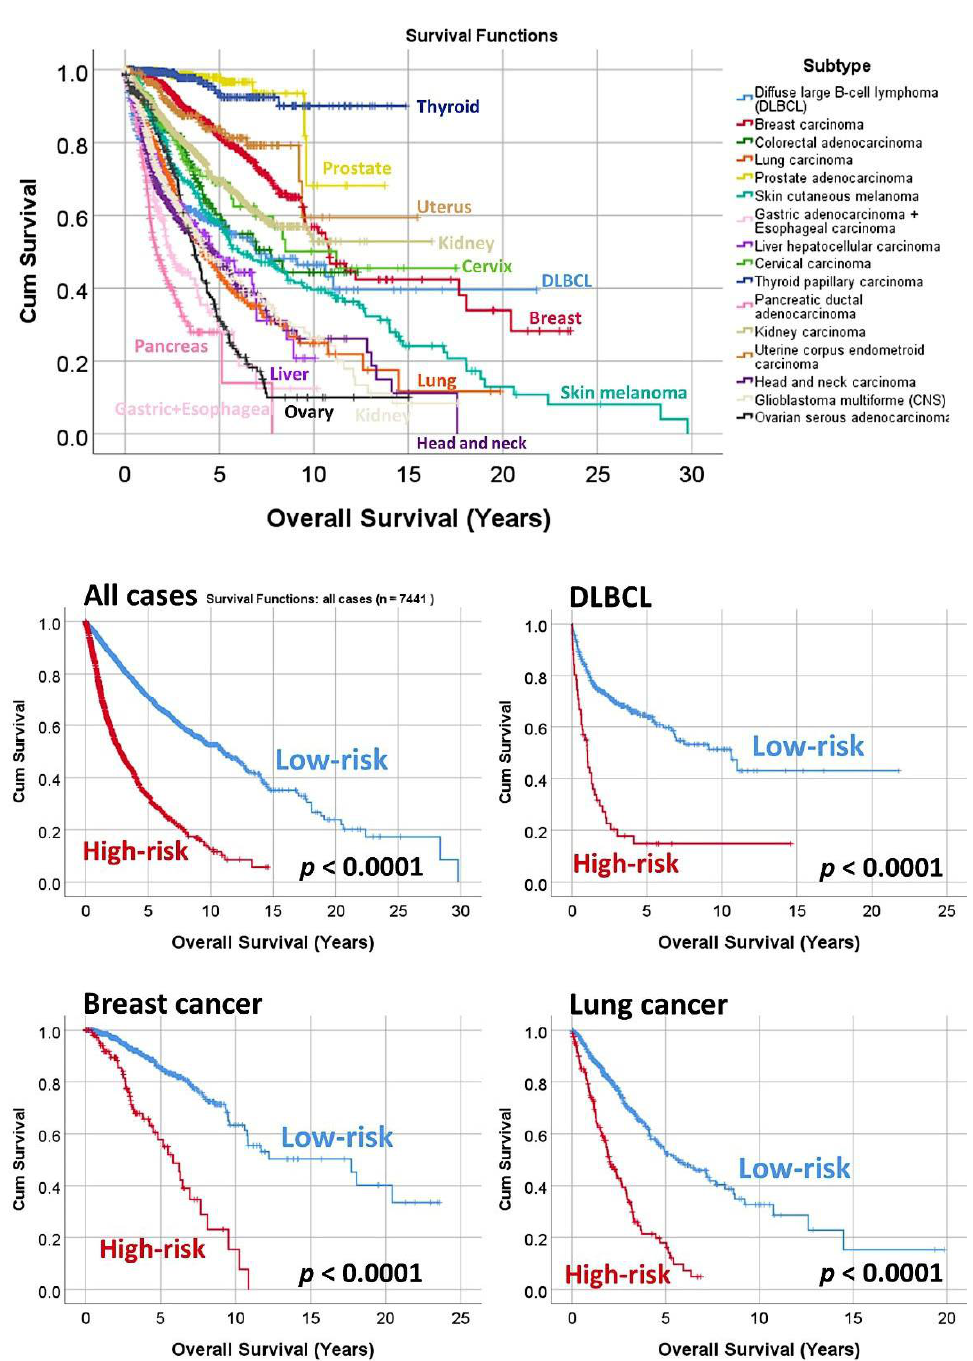
Figure 8. Predictive value for the overall survival of the top 30 genes of the MLP. Using the gene expression of 30 genes, previously identified by the MLP analysis, and a risk-score formula, the overall survival of diffuse large B-cell lymphoma and the most relevant subtypes of cancers were calculated. All cases, Log-rank (Mantel–Cox) p -value = 5.1 × 10 − 202 ; DLBCL, p = 5.7 × 10 − 15 ; breast cancer, p = 1.4 × 10 − 16 ; lung cancer, p = 4.5 × 10 − 20